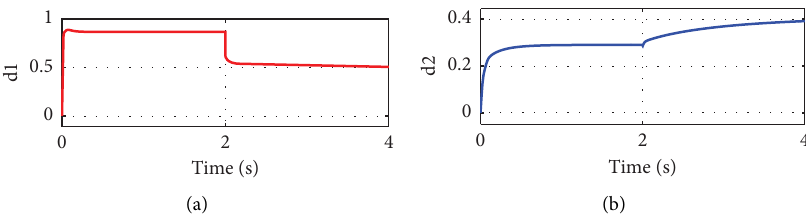
Figure 15: Duty cycles in the frst operation mode. (a) Duty cycle of S1 and (b) duty cycle of S2.